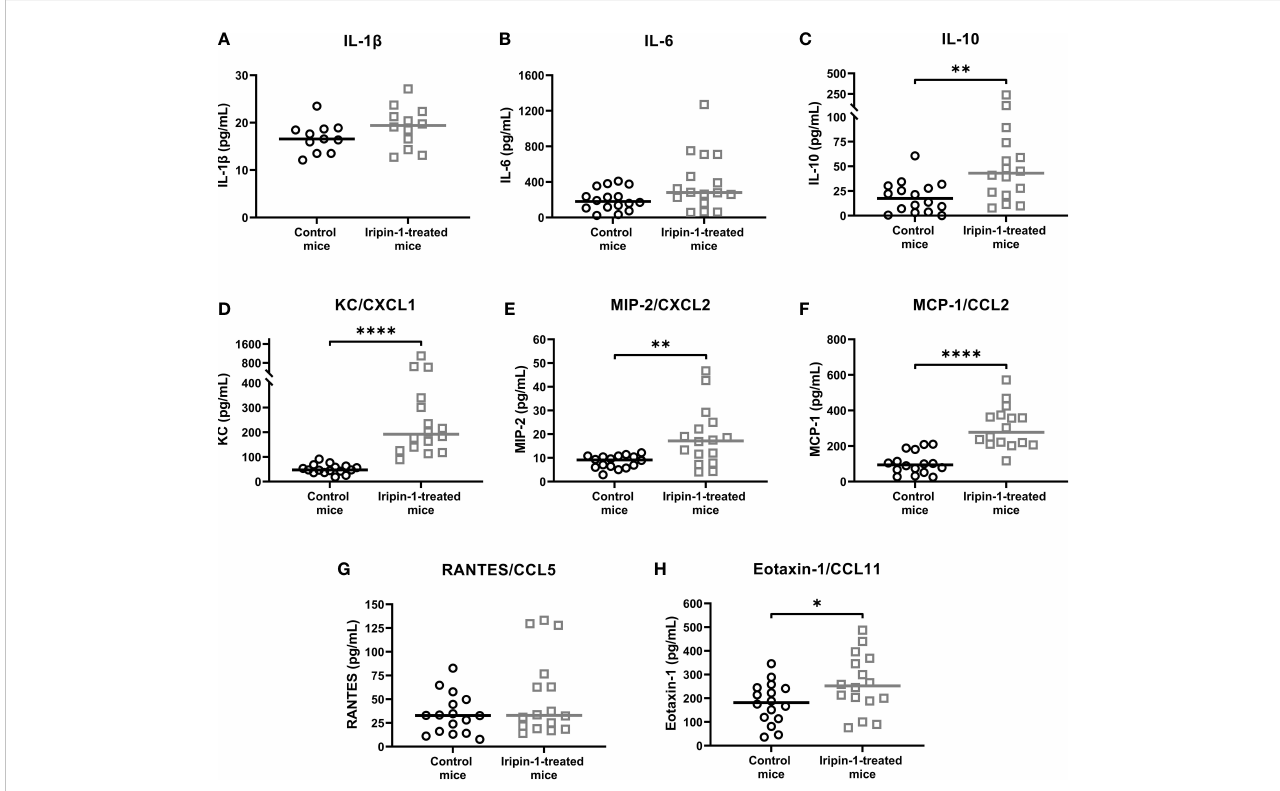
FIGURE 7 Iripin-1 alters cytokine and chemokine production in the thioglycolate-induced peritonitis model. Mice were injected ip with Iripin-1 (2 mg/kg) or the corresponding amount of control buffer, and peritonitis was induced with ip injection of 200 m L 3% thioglycolate medium (TGM). Peritoneal lavage was performed 4 h after TGM administration, and concentrations of pro-in fl ammatory cytokines IL-1 b (A) and IL-6 (B) , the anti-in fl ammatory cytokine IL-10 (C) , and chemokines KC (D) , MIP-2 (E) , MCP-1 (F) , RANTES (G) , and eotaxin-1 (H) in the peritoneal lavage fl uid were determined by sandwich ELISA kits. Each control mouse is represented by one black-lined circle, and each Iripin-1-treated mouse is represented by one grey-lined square. The black and grey horizontal lines mark the median values. Asterisks indicate statistically signi fi cant differences between the two groups (*p < 0.05, **p < 0.01, ****p <